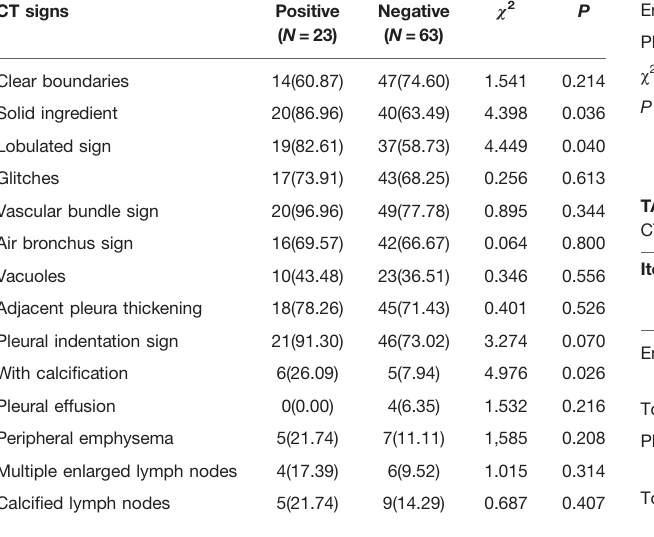
TABLE 1 | Relationship between different CT features of lung adenocarcinoma and vascular tumor thrombus [ n (%)].